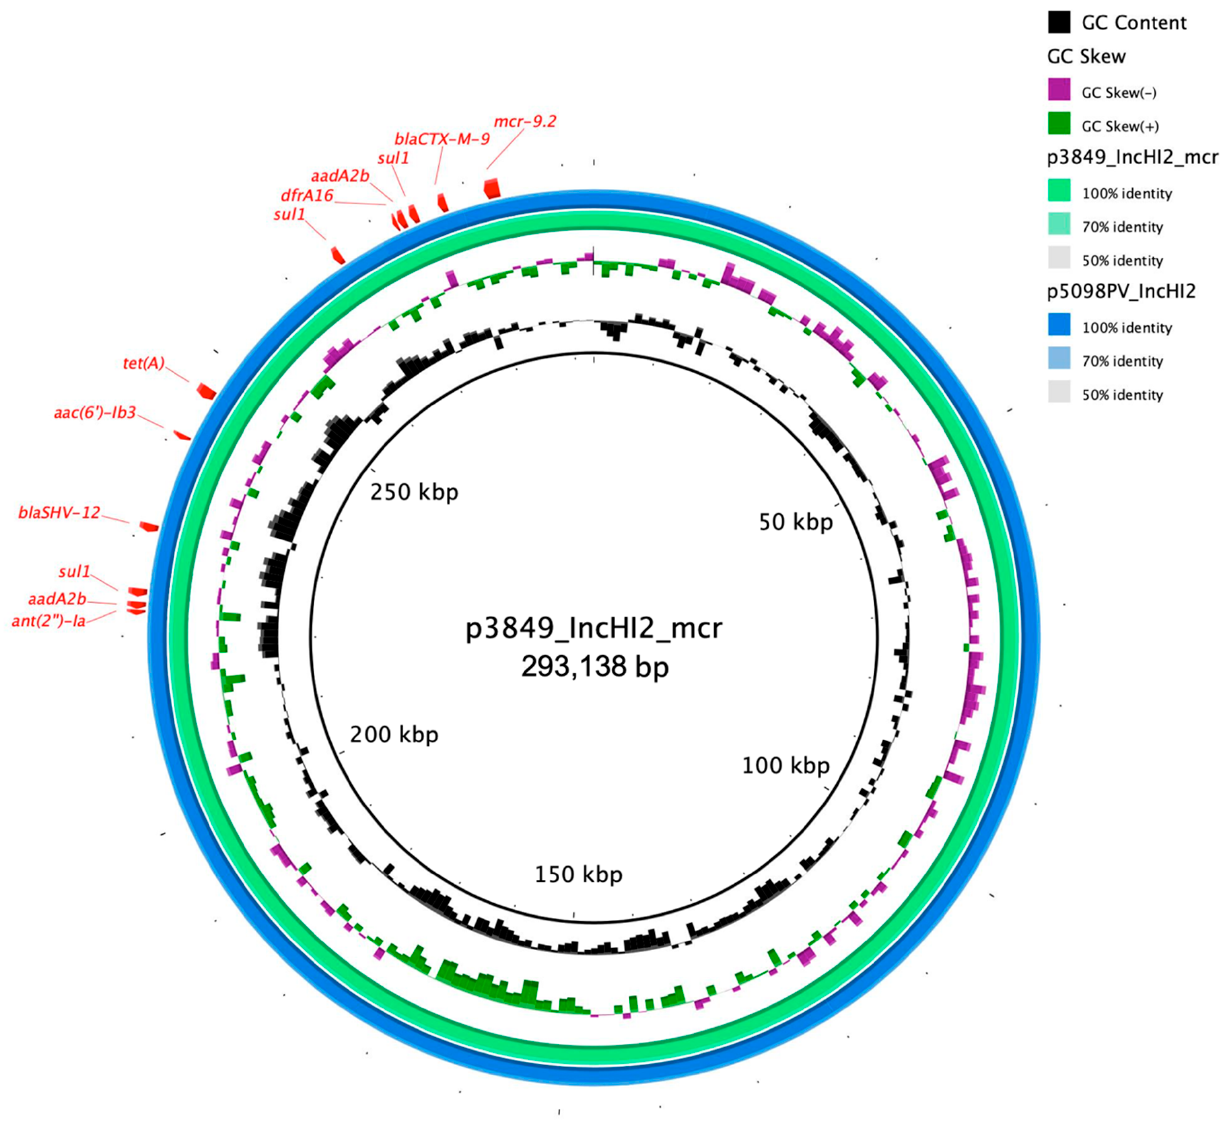
Figure 3. The circular map of p3849_IncHI2_mcr (green) against p5098PV_IncHI2 (blue). The outer most curved segments; red, correspond to antibiotic resistance genes.